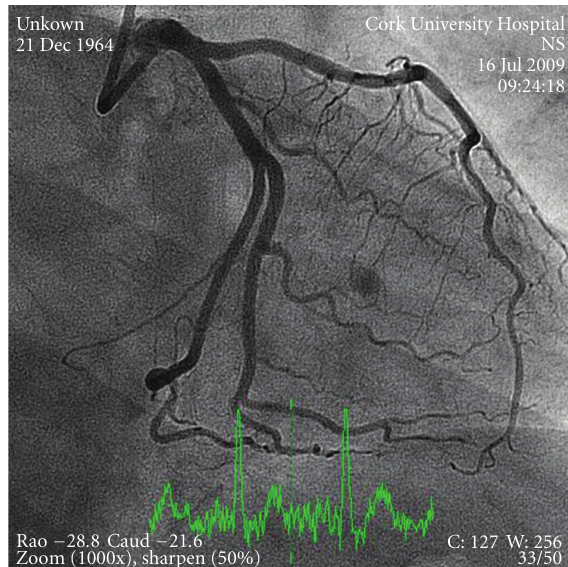
Figure 2: Similar projections showing resolution of thrombus with normal underlying coronary